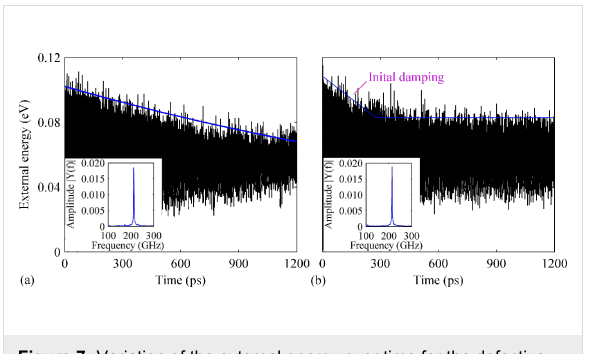
Figure 7: Variation of the external energy over time for the defective GNR (two vacancies) with both B- and N-dopants. The total dopant densities are (a) 0.89% and (b) 2.02%. The insets show the corres- ponding frequency spectra.